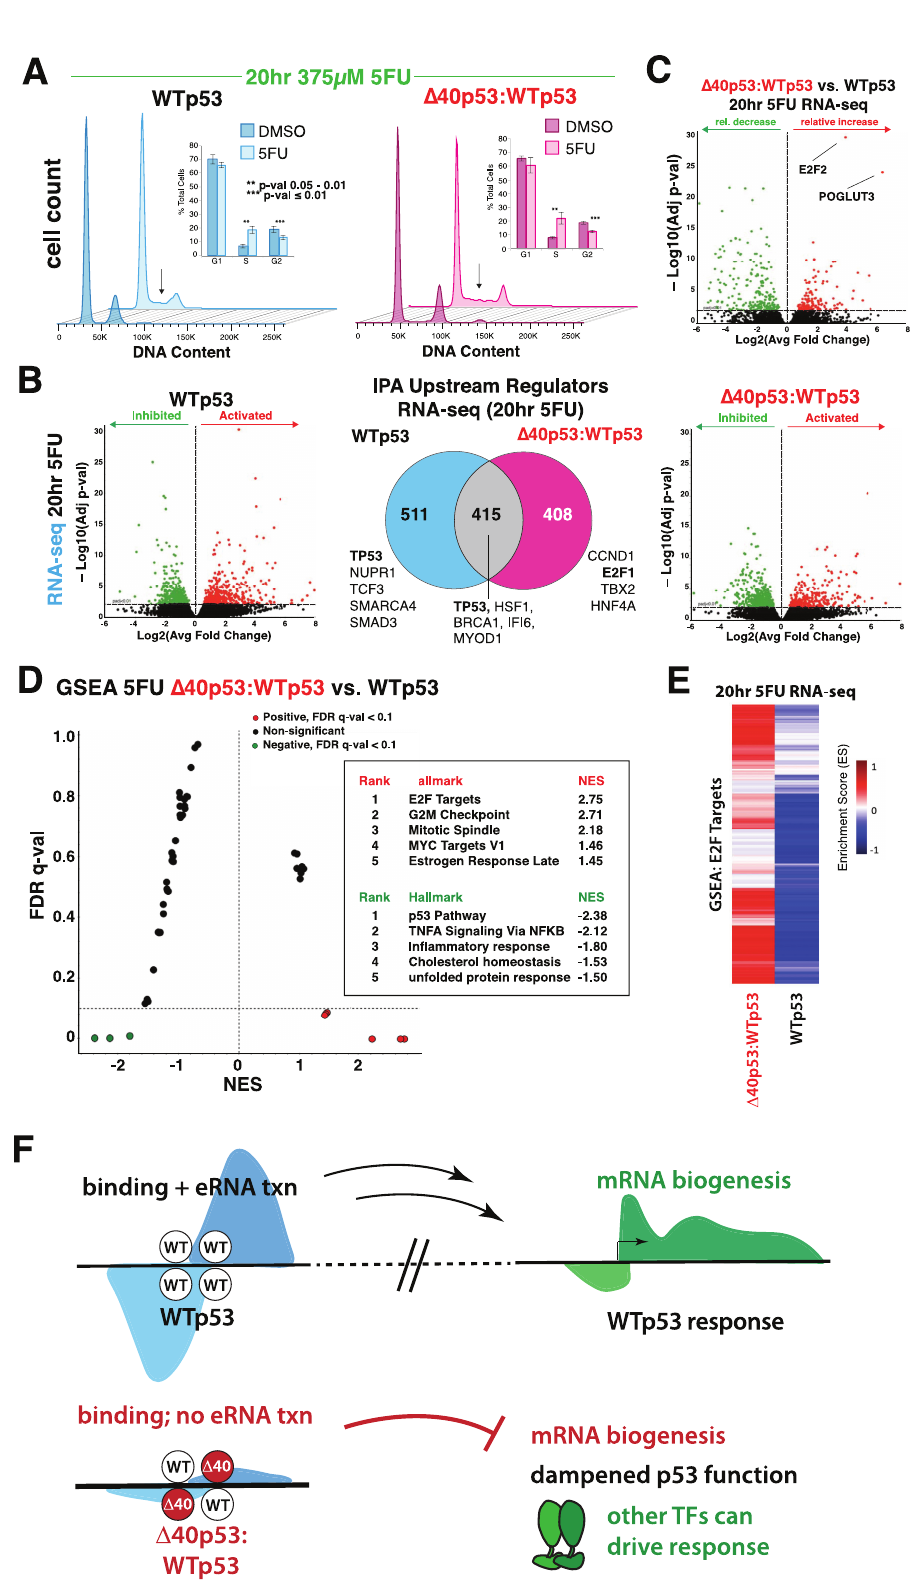
Fig 4. Cellular response to 5FU similar in WTp53 vs. Δ 40p53:WTp53 cells, but driven by distinct TFs. (A) Cell cycle analysis (PI); chart (inset) represents the average of 3 experiments (bars = SEM). Arrows highlights increased